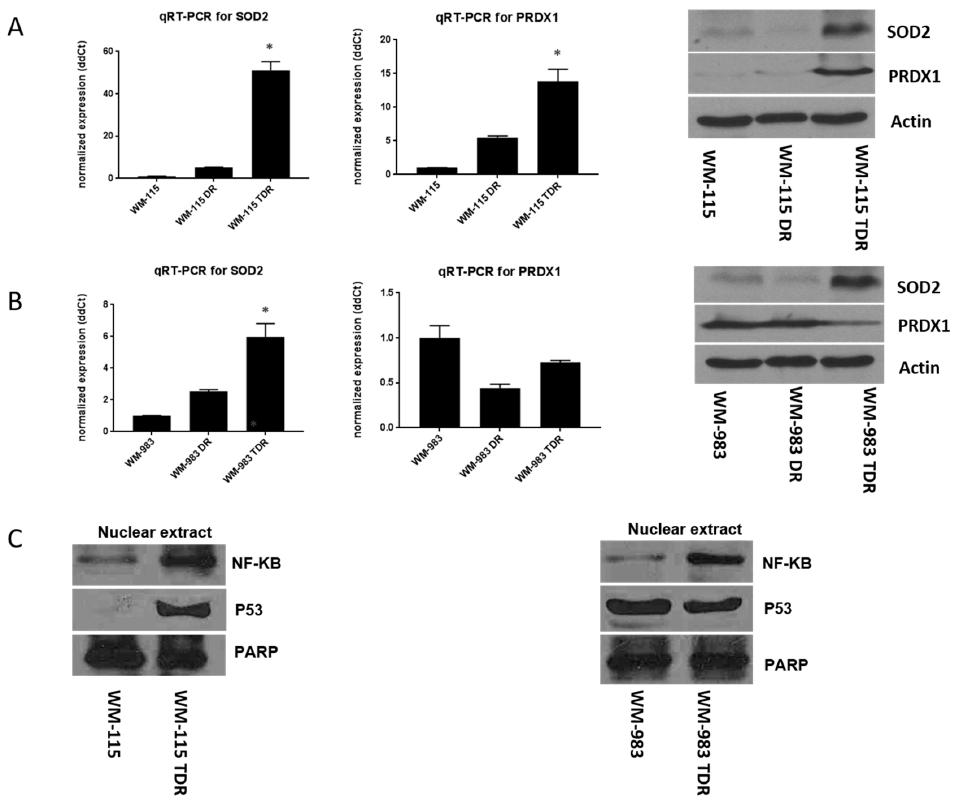
Figure 4. Superoxide dismutase 2 (SOD2) and NF- κ B levels are increased in BRAF pathway inhibitor-resistant cells. ( A ) An equal number of WM-115 (parental, DR, and TDR) cells were plated. Total RNA was extracted from these cell lines using the RNA extraction mini kit, according to the manufacturer’s instructions. Two-step real time-qPCR was performed to assess the mRNA level of SOD2 and PRDX1. First strand cDNA was synthesized using the iScriptTM cDNA synthesis kit qPCR, which was set up using the CFX96 real-time system. Actin was used as an internal control. Relative SOD2 and PRDX1 expression was presented by the 2 − ∆∆ CT method (left panel). In separate experiments, whole cell lysates were prepared and separated in a 12.5% sodium dodecyl sulfate (SDS) gel, followed by immunoblot analysis with indicated antibodies. Western blot data is shown on the right panel. ( B ) An equal number of WM-983, WM-983 DR, and WM-983 TDR cells were plated. Two-step real time-qPCR and immunoblot analysis with indicated antibodies were performed under the above conditions (left and right panels). ( C ) Nuclear extracts were collected and prepared from WM-115 and WM-983 (parental and TDR). * p < 0.05 versus parental cell lines. Statistical analysis by one way ANOVA.